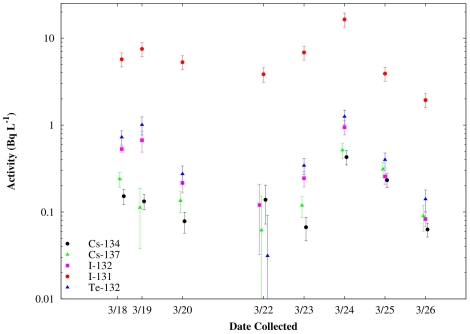
Activity concentrations of 131,132I, 132Te, and 134,137Cs in Bq L−1 measured in San Francisco Bay area rain water as a function of time.